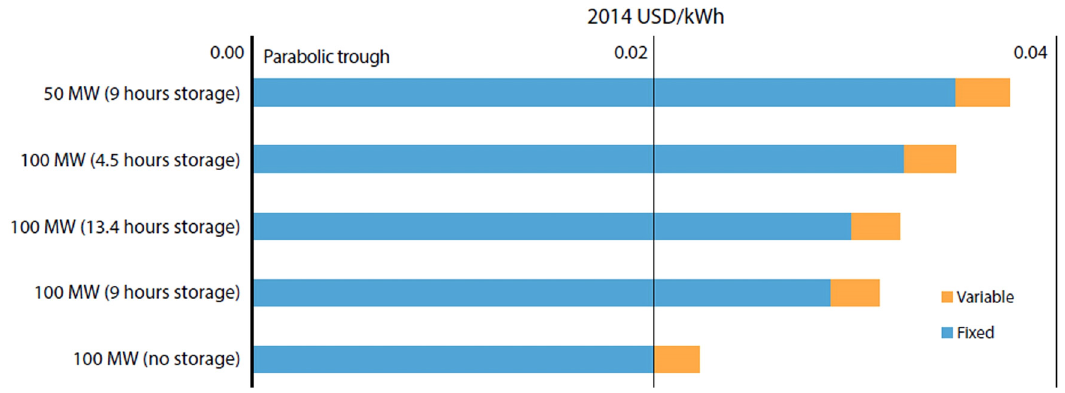
Figure 24: O&M costs for CSP with PTC. ( Retrieved from: IRENA ( 2015 ) , Renewable Power Generation Costs in 2014 [ 1 ] . )